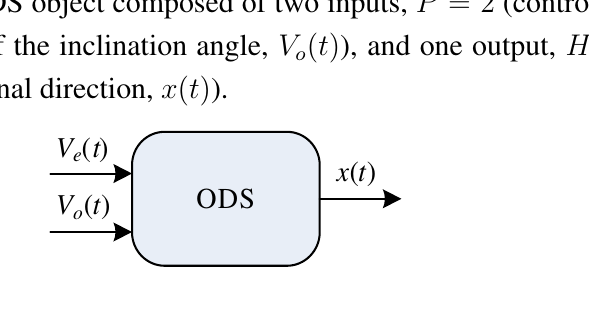
( t ) ), and one output, H = 1 (speed of o